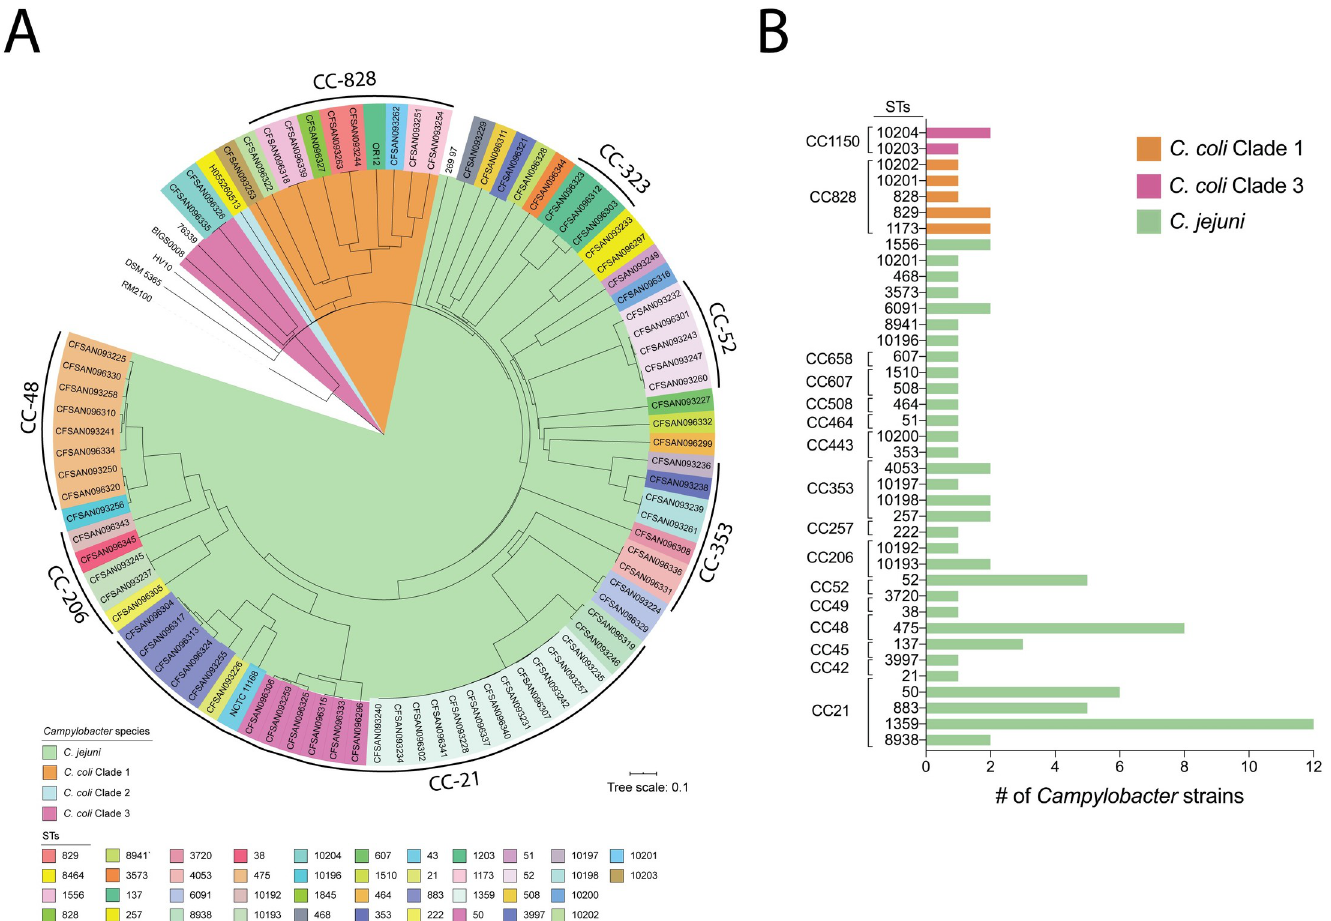
Fig 1. Phylogenetic analysis of clinical C . jejuni and C . coli strains from Chile. Phylogenetic tree is based on cgMLST performed with RIDOM SeqSphere + and visualized by iTOL. STs are shown in colored boxes for each strain, and tree branches are color coded to highlight C . jejuni and C . coli strains from clades 1, 2 and 3. ST and CC frequency distribution of clinical C . jejuni and C . coli strains from this study are detailed in the right panel.